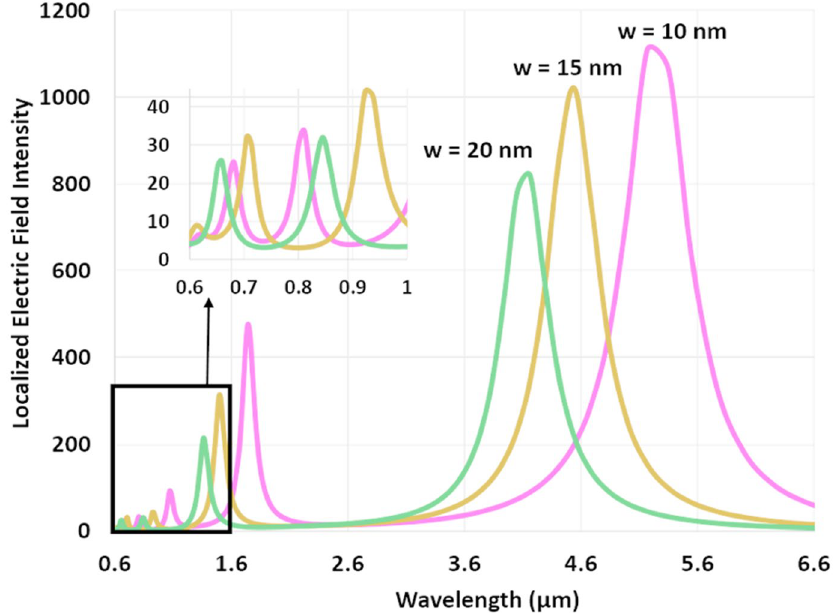
Figure 4. Resonance spectrum of a single groove for different groove widths ( w ) and groove depth ( L ) = 500 nm. Wavelength and localized intensity in the groove cavity increase as w